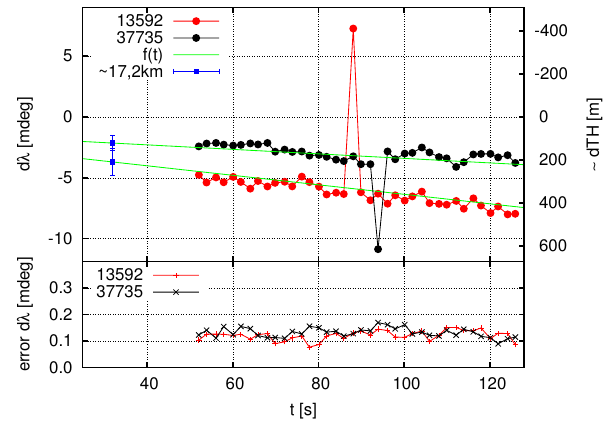
Fig. 8. The top panel shows the fitted EAOs versus measurement time as in Fig. 6, but for the occultation states for the orbits 13592 (5 October 2004) and 37735 (19 May 2009). Both show an outlier in the individual scans. The lower panel shows the error on t cen for the individual fits (converted to an error on the EAO using the scan